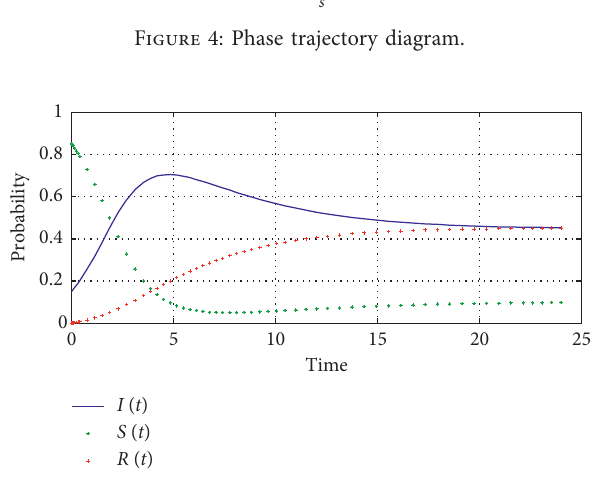
Figure 5: Change of I ( t ) , S ( t ) , and R ( t )